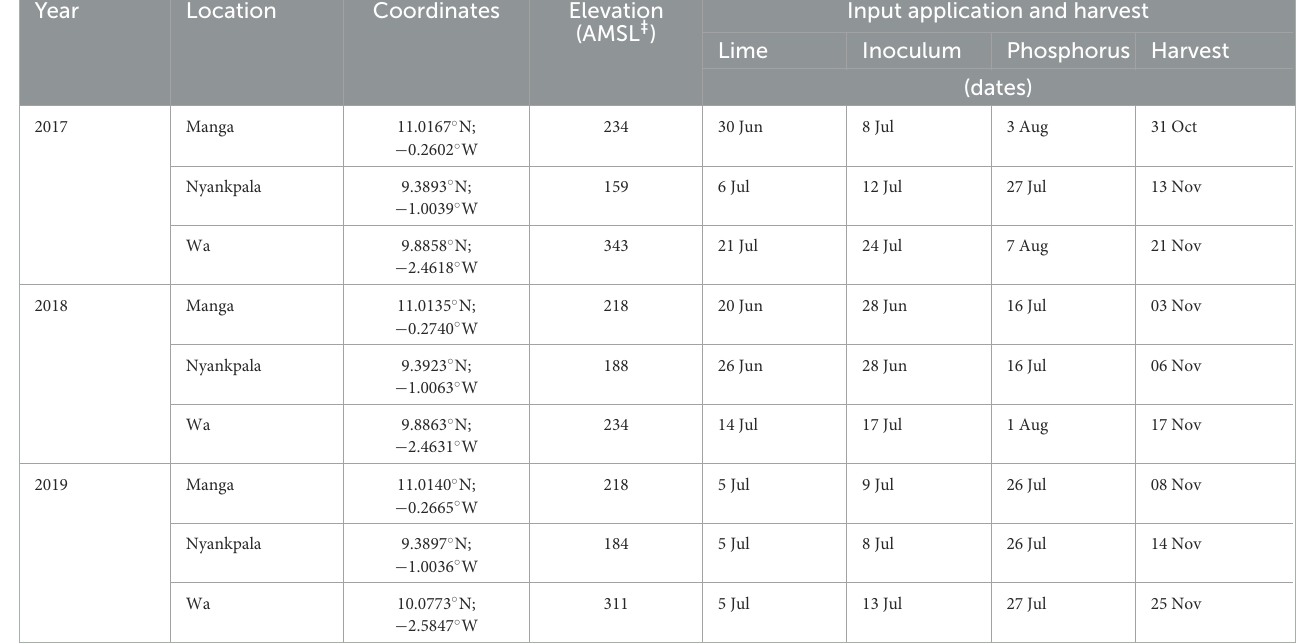
TABLE 1 Site-specific coordinates, elevation, input application, and harvesting dates at Manga, Nyankpala, and Wa in northern Ghana (2017–2019).